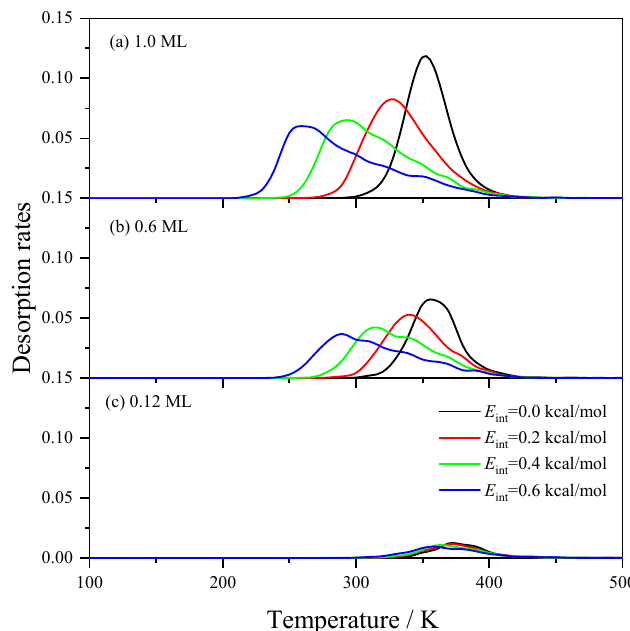
Figure 6. Effects of the lateral interactions among H(a) on the H 2 TDS spectra. v = 10 13 s − 1 , E a = 22 kcal/mol.